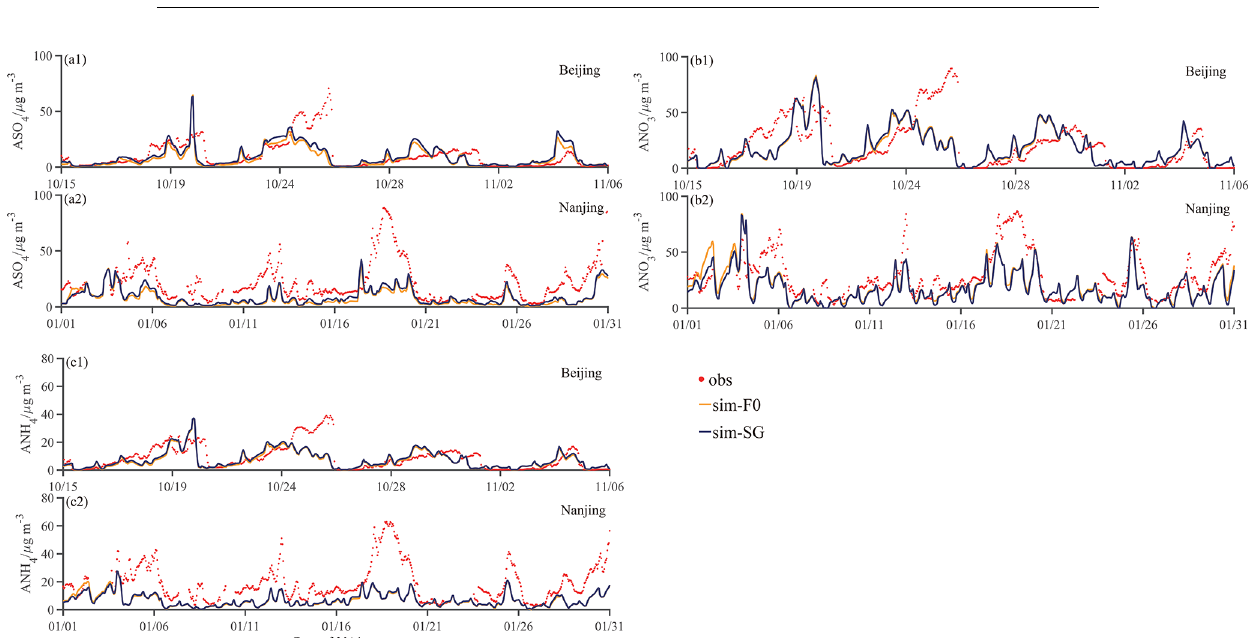
Figure 7. The same as Fig. 5, but for Beijing and Nanjing in cold seasons.